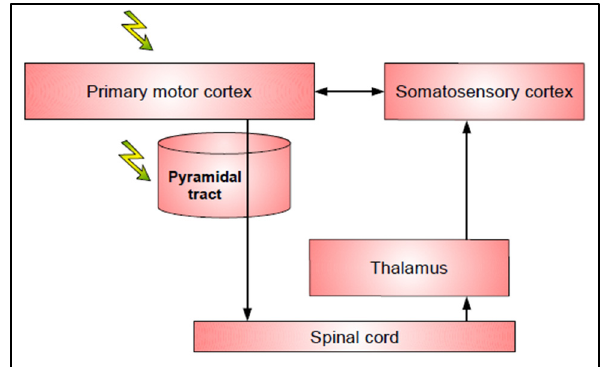
Figure 1. First level of neural disruption by DES: motor output. Flashes represent sites eliciting positive motor responses with DES.